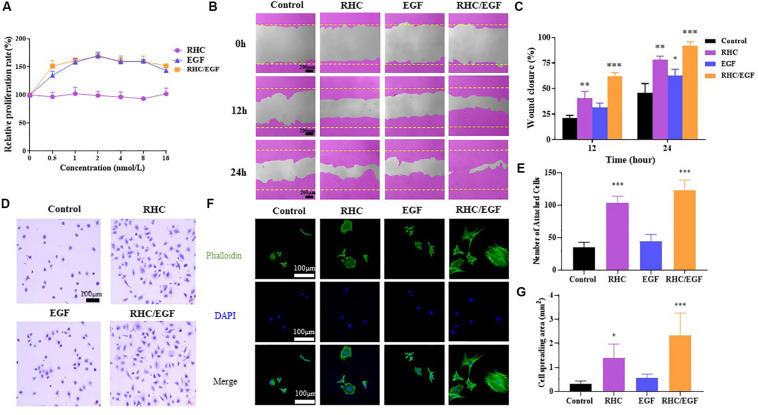
Cell biological activity of RHC/EGF (1:1). (A) MTT assay of NIH/3T3 cell proliferation rates on RHC, EGF, or RHC/EGF. (B) Images obtained at 0, 12, and 24 h after wound creation in vitro migration assay on RHC, EGF, or RHC/EGF. (C) Quantitative analysis of gap area of HaCaT cells cultured on RHC, EGF, or RHC/EGF. (D) Optical micrographs of crystal violet–stained NIH/3T3 cells adhering to monolayers. (E) Quantitative detection of the number of adherent NIH/3T3 cells. (F) Cytoskeleton staining. (G) Quantitative calculation of cell spread area. n = 3, means ± SD, ∗P < 0.05, ∗∗P < 0.01, ∗∗∗P < 0.001 vs. control group.